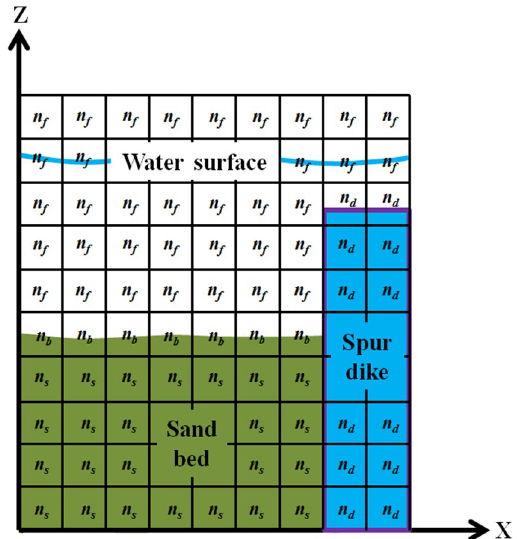
Figure 1. Porosity definition in the computational domain.